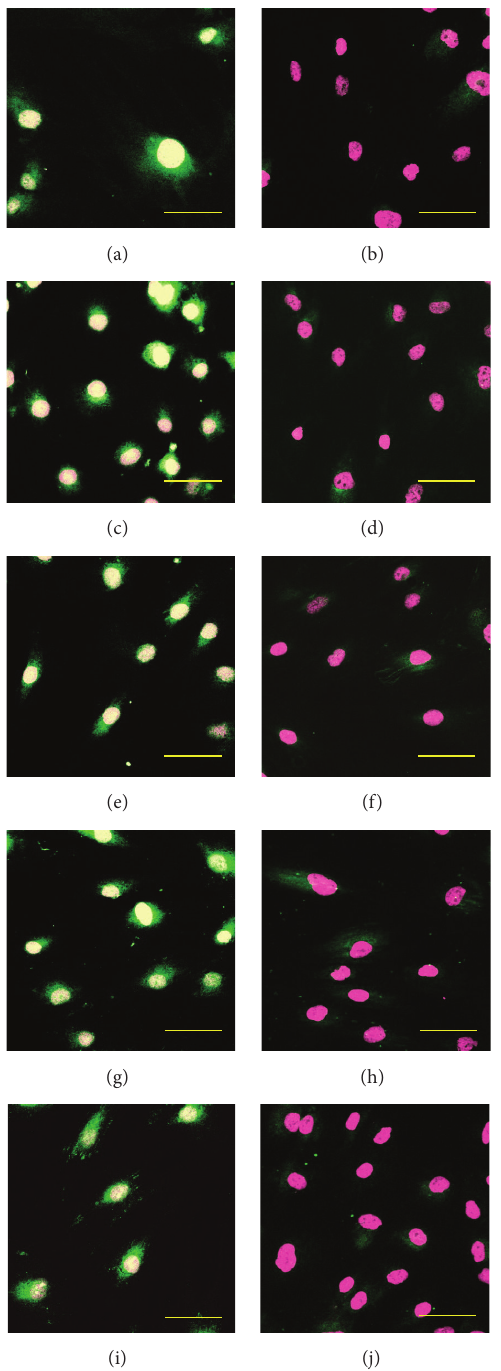
Figure 27: Immunofluorescence staining of ESCs markers. Immunofluorescence staining of Nanog (a), POU5F1 (c), SOX2 (e), KLF4 (g), and LIN-28A (i) of the cell line of OSA3-CSCs. (b, d, f, h, and j) Negative controls, respectively, for each marker. LSCM in conventional colors: green for ESCs and pink for nuclei. Original magnifications: 20x. Bar size: 100 𝜇